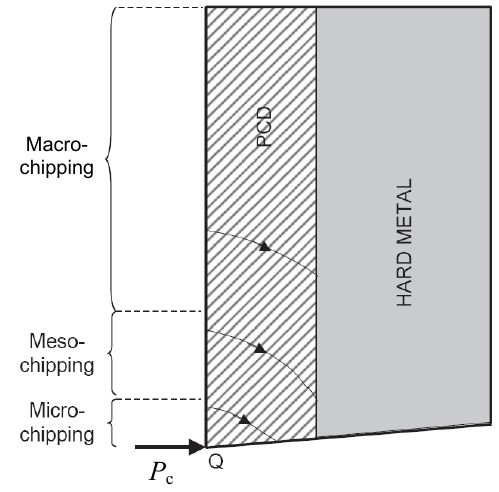
Figure 6. Sketch of a PCD bit used in cutting tools (reprinted with permission from [8]). and different possible failure modes ranging from The critical impact load is denoted by P c micro- to macro-chipping are